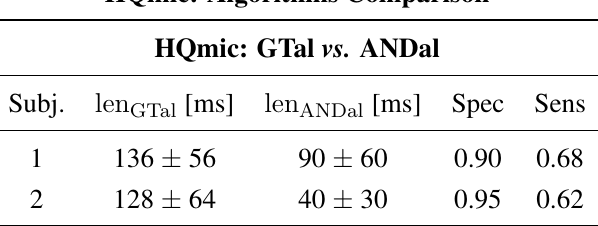
Table 3. HQmic, algorithms comparison: segment lengths (median ± MAD), specificity (Spec) and sensitivity (Sens) as estimated on high quality data using both